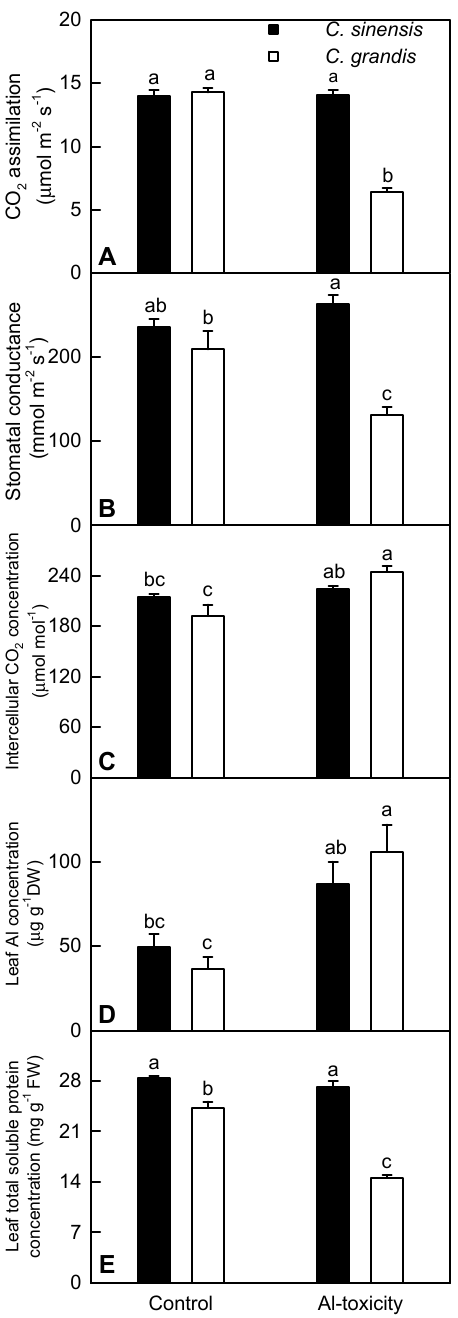
Figure 1. Effects of Al toxicity on leaf CO 2 assimilation ( A ); stomatal conductance ( B ); intercellular CO 2 concentration ( C ); Al ( D ) and total soluble protein ( E ) concentrations. Bars represent the means ˘ standard error SE ( n = 5). DW: dry weight; FW: fresh weight. Differences among four treatment combinations (two species ˆ two Al) were analyzed by two-way analysis of variance. Means were separated by Duncan’s new multiple range test. Different letters above the bars indicate a significant difference at p <